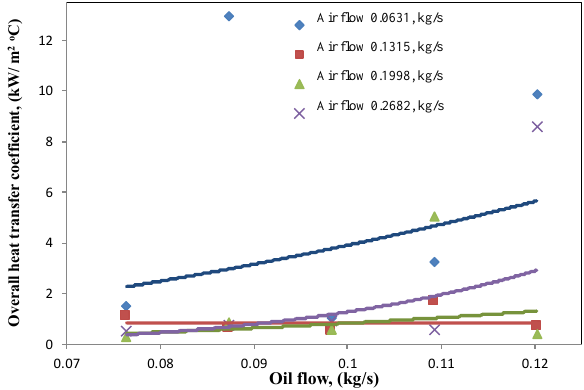
Figure 24. Average absorber tube overall heat transfer coefficient.